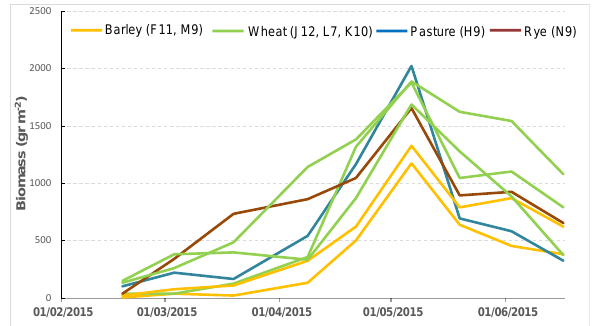
Figure 6. Biomass evolution for the seven plots clustered by type of